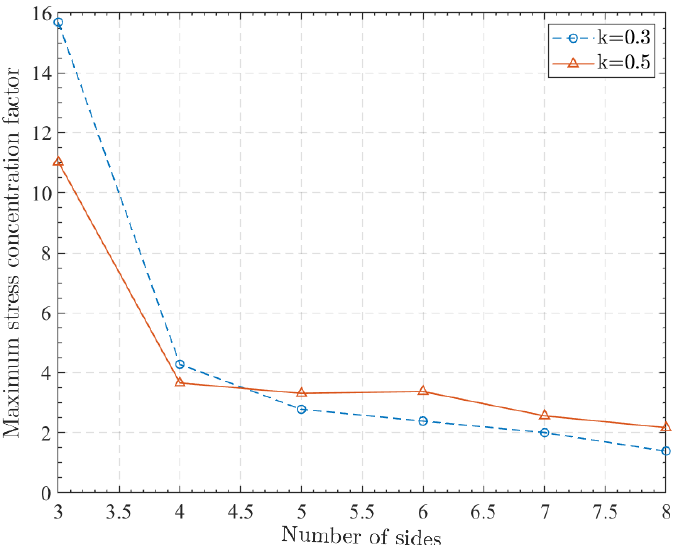
Figure 5. Graph of the maximum stress concentration factor around the hole as a function of the number of sides.